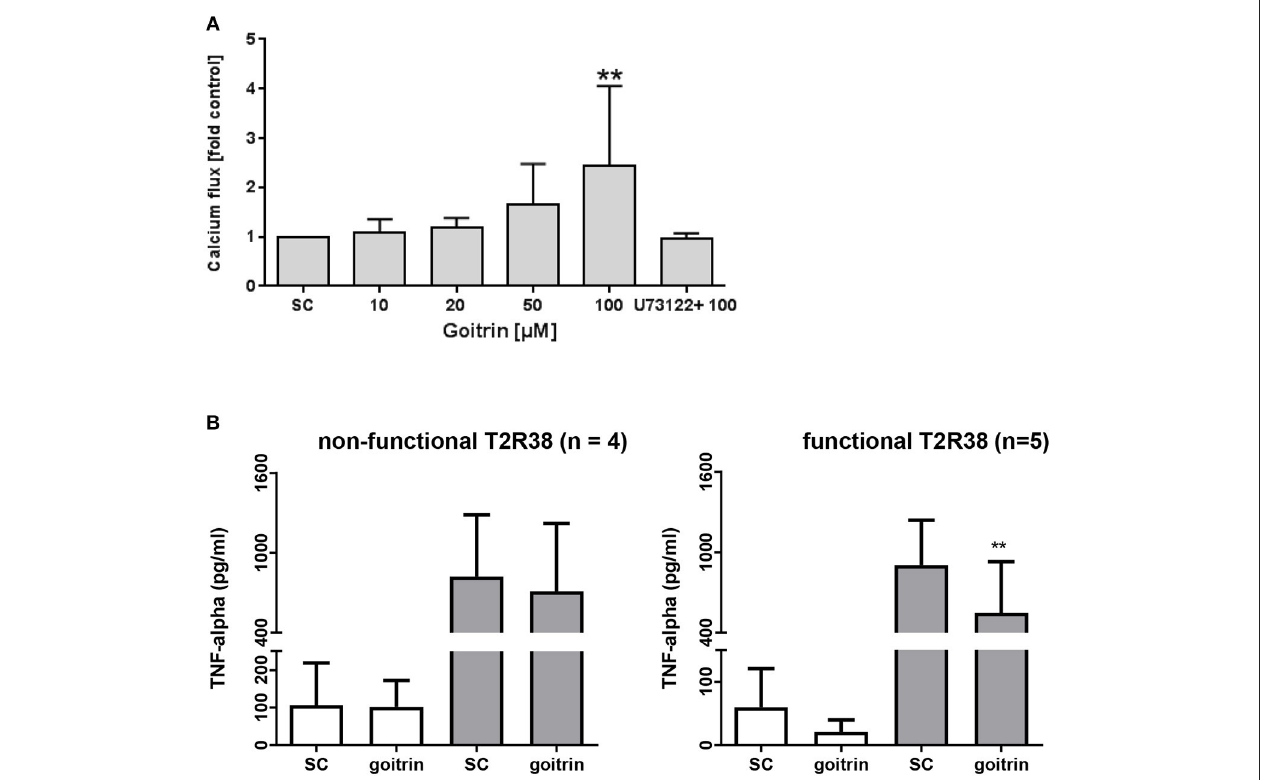
FIGURE 4 | Analysis of calcium flux and TNF-alpha secretion. (A) FACS-based measurement of calcium flux was detected in lymphocytes (PAV haplotype) probed with Fluor-4 AM (F EM : 516nm) after treatment with different concentrations of goitrin alone or 1h pre-incubation with 10 µ M PLC- β 2 inhibitor U73122. Baseline fluorescence was recorded for 60s before addition of goitrin and fluorescence was measured for a total of 800s. Calcium response was calculated as the ratio of the maximum peak post stimulation to basal level using FlowJo software. The gating strategy is shown in Supplementary Figure S4 . Bars are means + SD , n ≥ 8. Significance of difference was calculated relatively to the respective control, * p < 0.05. ( B) PBMC with functional (PAV haplotype) and non-functional (AVI/AVI) T2R38 receptor were exposed to 100 µ M goitrin or 0.01% DMSO for 72h w/wo IL-2 and TNF-alpha secretion was analyzed using an ELISA kit. Results are mean values + SD , ** p < 0.01. Significance of the difference was determined compared to the respective solvent control (SC, 0.01%